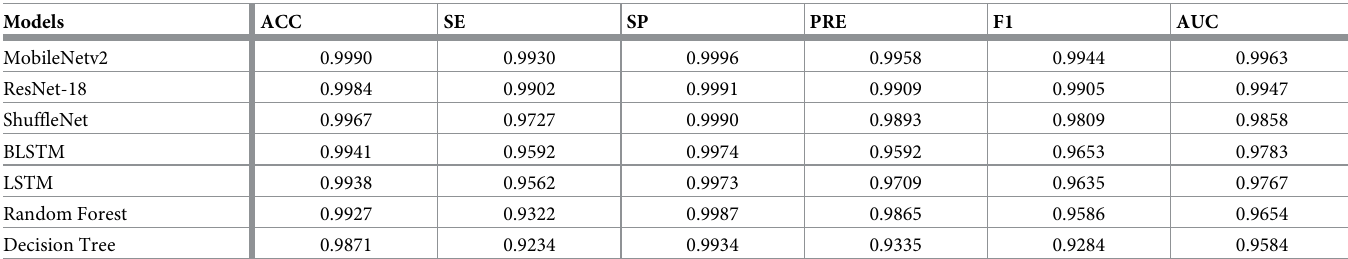
Table 11. Final results (1 st experiment).